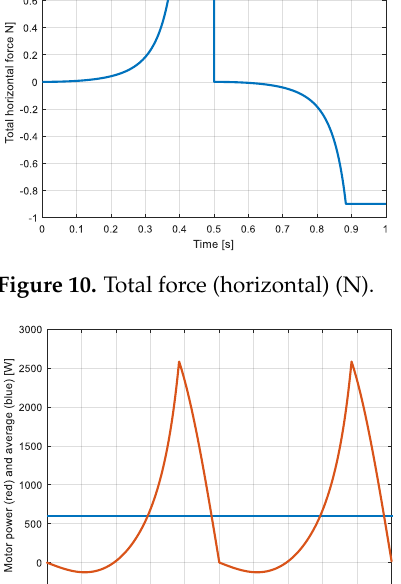
Figure 11. Power received by the two pistons (W). red: power, blue: average value).